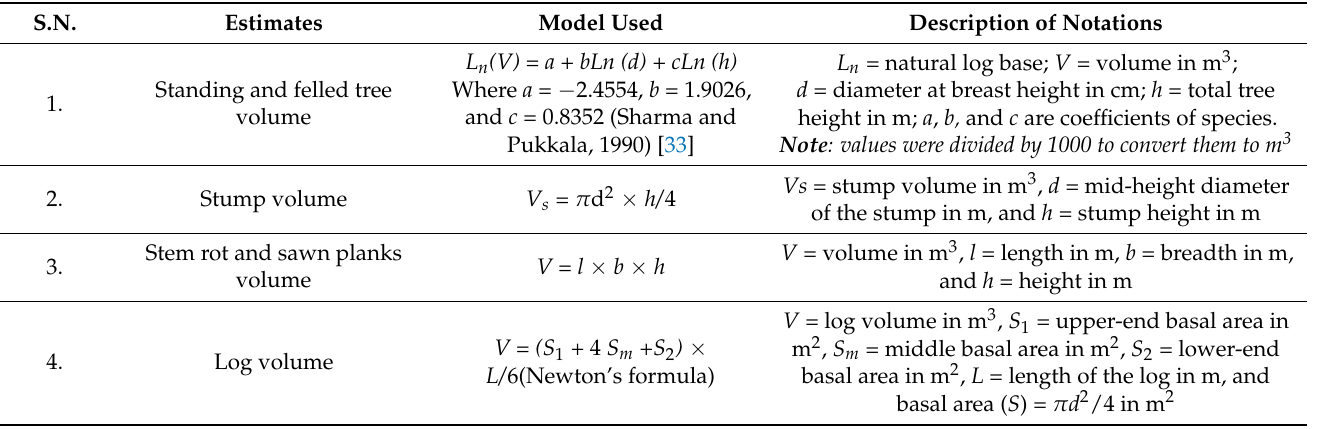
Table 1. Table showing equations used to estimate different